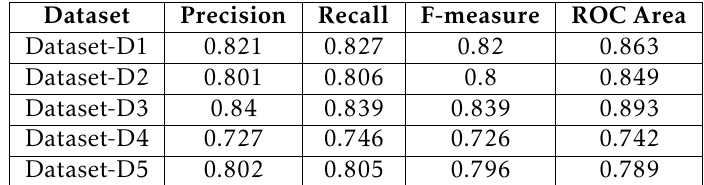
Table 2. The prediction results for Support Vector Machine (SVM)